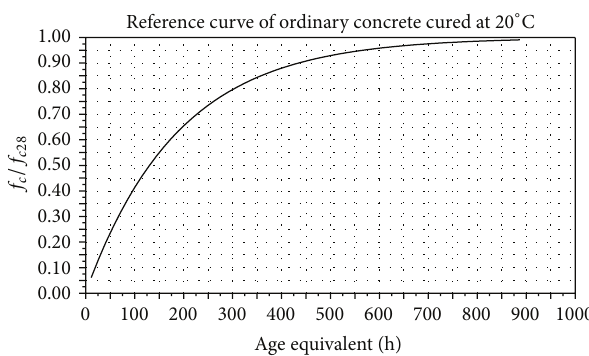
Figure 4: Reference curve of ordinary